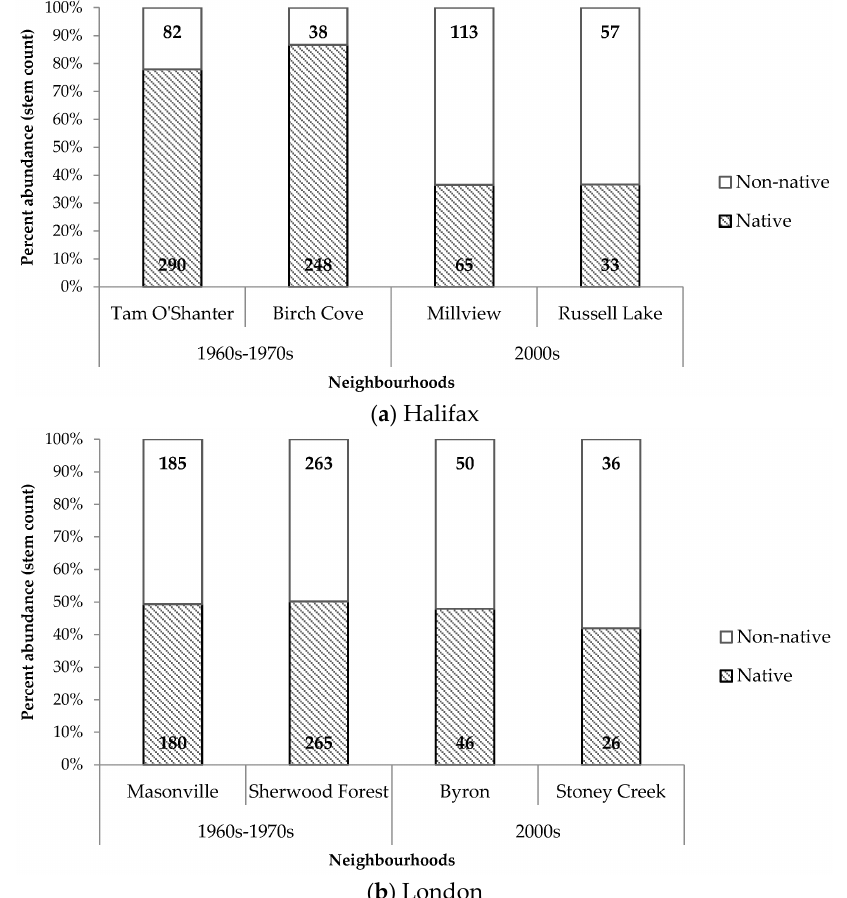
Figure 7. Counts and proportions of native and non-native trees for residential property trees in each neighbourhood: ( a ) Halifax; ( b ) London. Table 5. Diversity indices of residential property tree communities combined according to neighbourhood.